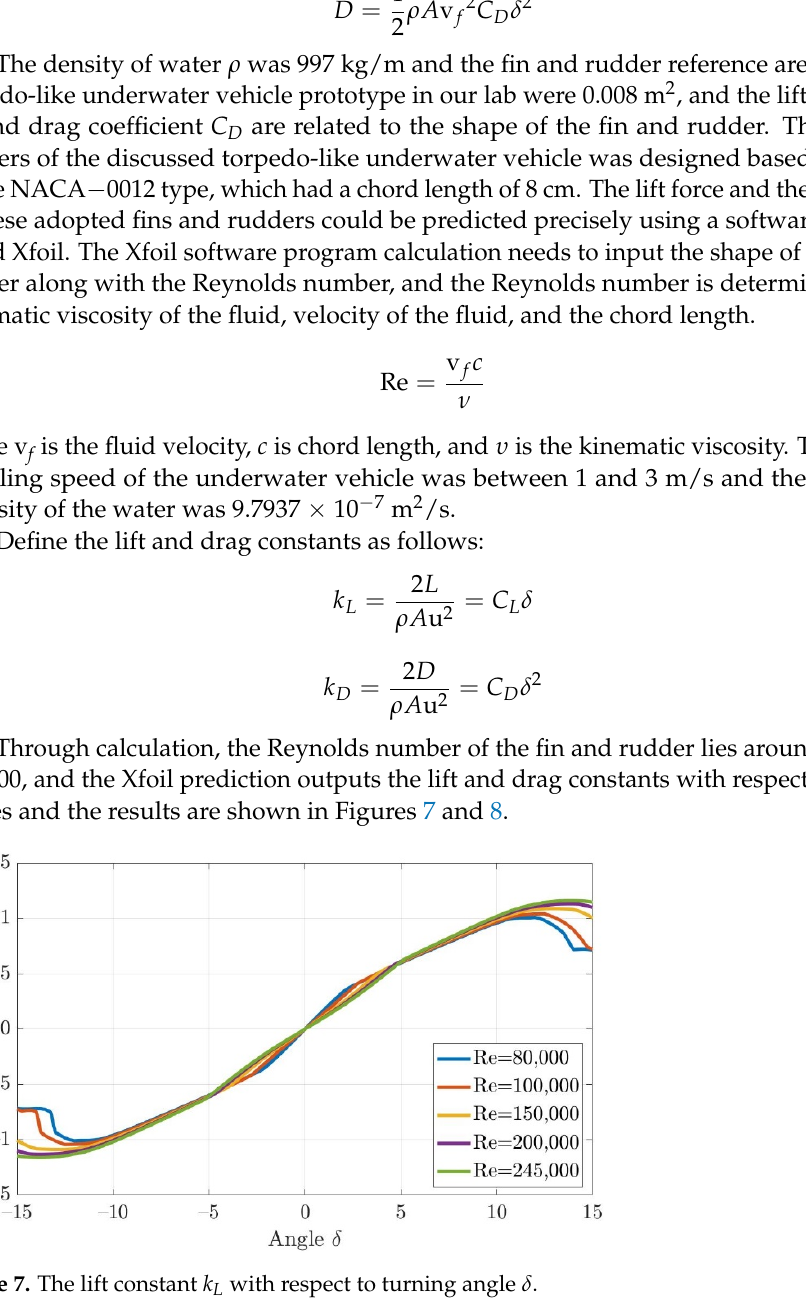
Figure 8. The drag constant k D with respect to turning angle δ . By using the approximation method for Figures 7 and 8, the lift coefficient and drag coefficient could be estimated as